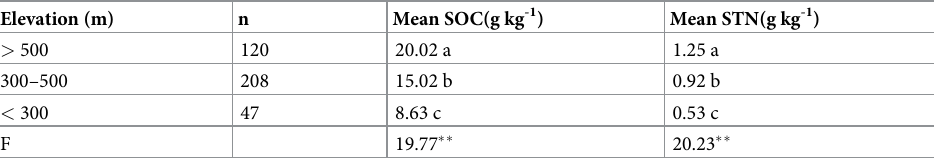
Table 4. Comparison of the means of topsoil SOC and STN concentrations of different elevation groups. Elevation (m) n Mean SOC(g kg -1 ) Mean STN(g kg -1 ) > 500 < 300 47 F 19.77 �� 20.23 �� Different letters in the same column indicate significant differences at P < 0.01. �� P < 0.01.